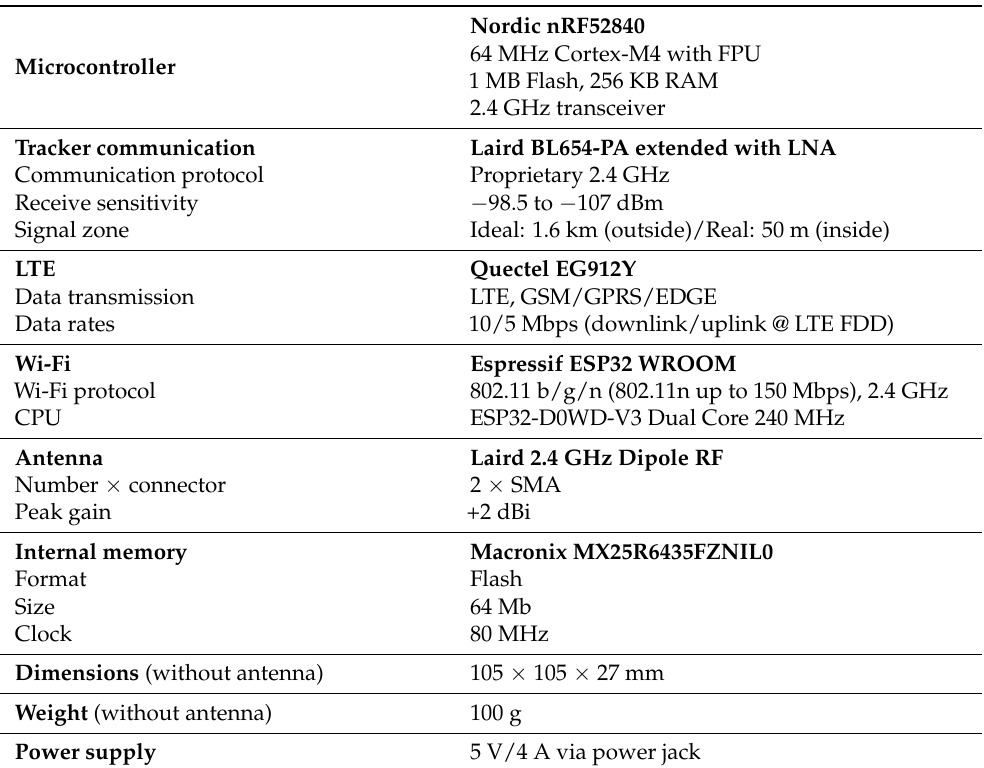
Figure 5. Detection gateway—block diagram and realized printed circuit board (PCB): Power management—integrated circuit (IC) responsible for charging the battery and maintaining a stable supply of voltage for the MCU and other circuit logic; LTE/Wi-Fi—back-end communication; Rx 2.4 GHz—communication with tracking devices; Flash—long-term non-volatile storage for the MCU; User Interface—communication of status and syncing operation to the user; LAIRD BL654-PA—main MCU used to control the connected components and direct operations of the device. Table 2. Detection gateway parameters.